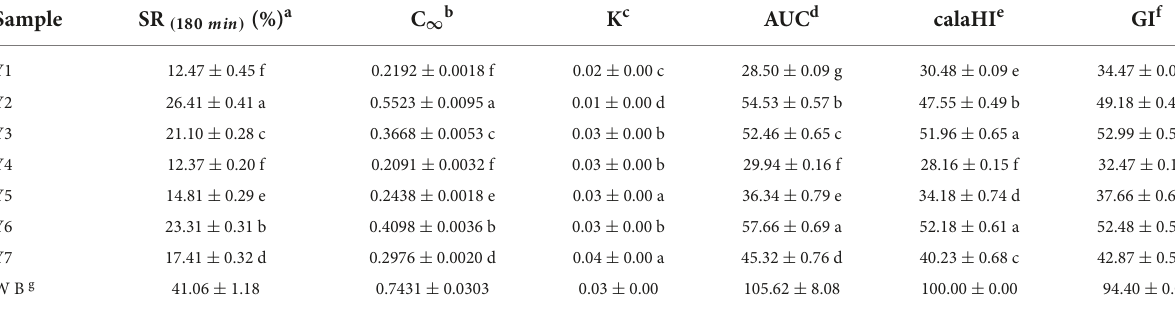
TABLE 3 Glycemic index (GI) and related indexes of kidney